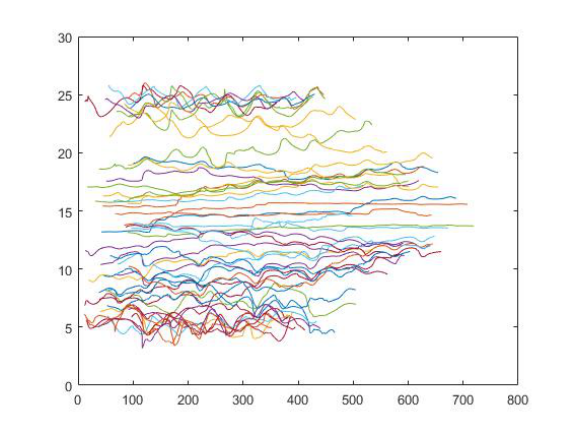
Fig. 14. Geometry A50, the location of the Z-coordinate of the cell centre in relation to X-coordinate.